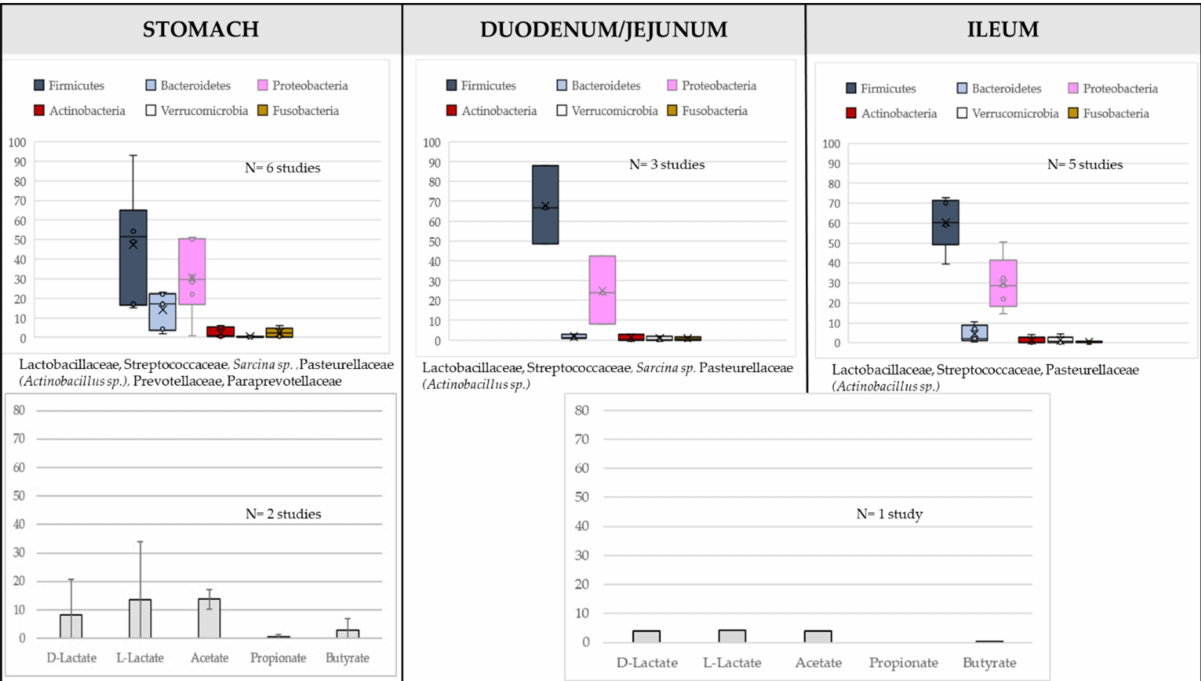
Figure 1. Main bacterial phyla and families (relative abundance, %) present in the upper tract of healthy adult horses and concentrations of the main organic acids found (expressed in